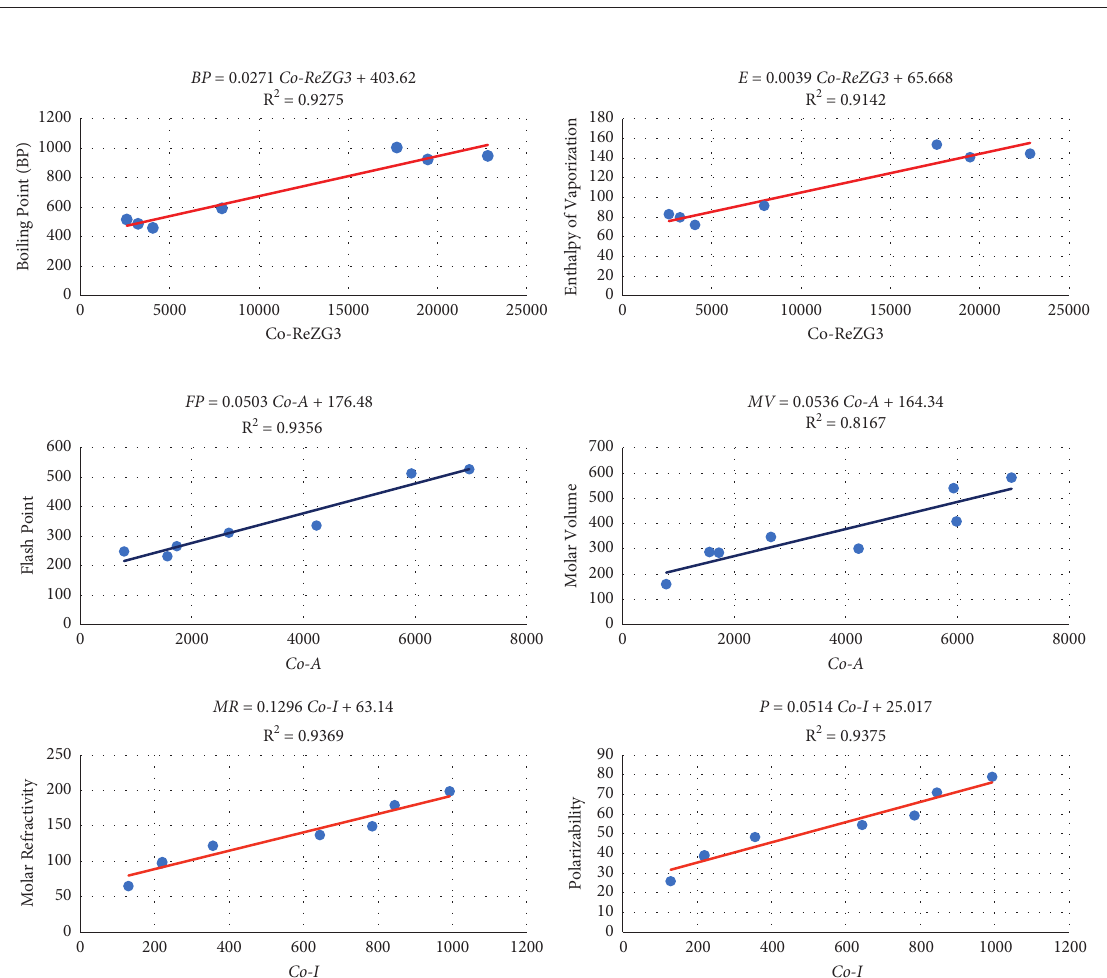
Figure 11: Plot of the most compatible fitting and predictive linear regression models for the different coindices with physicochemical properties of the drugs ( r ≥ 0 . 9 ) .